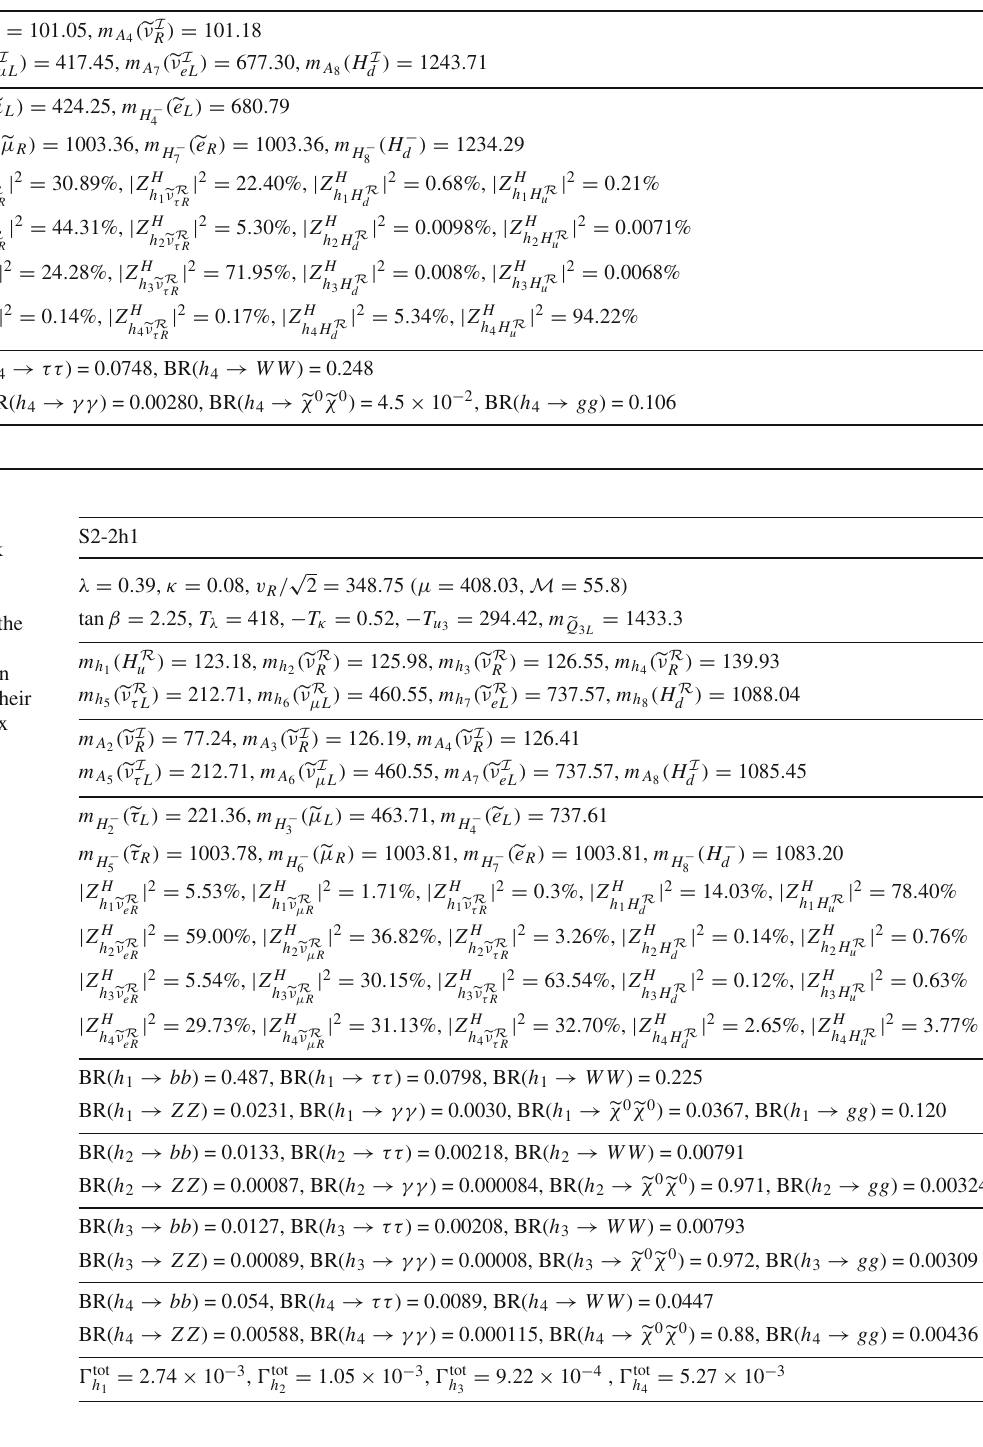
Table 9 The same as in Table 7, but for a benchmark point S2-B1 with the SM-like Higgs h 4 not being the lightest scalar S2-B1